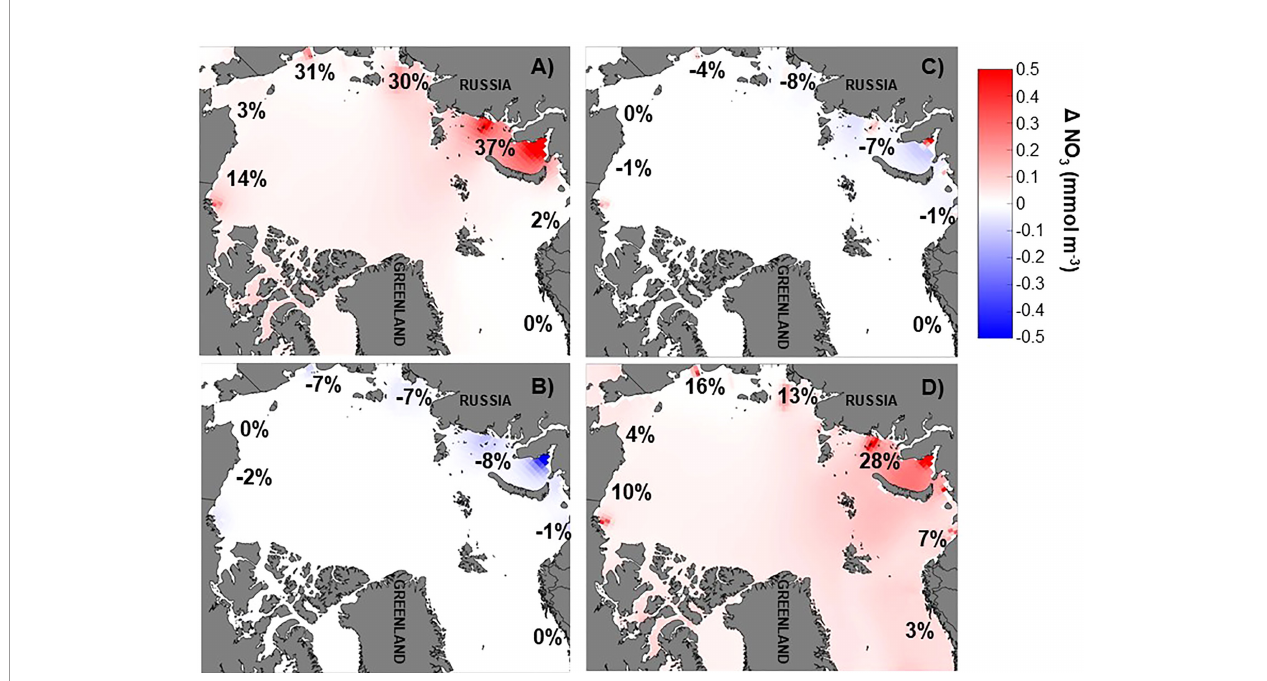
FIGURE 5 | Annual average nitrate anomaly (mmol m -3 ) in the upper mixed layer relative to the baseline run [(NO 3 ) EXP – (NO 3 ) BASE ] for (A) doubling of river nitrate (N X2 ), (B) annual river nitrate climatology (N CLIM ), (C) river nitrate climatology shifted earlier by two months (N CLIMS2 ), and (D) river nitrate climatology doubled and shifted earlier by one month (N CLIMX2S1 ). Red colors indicate increased nitrate over the baseline run while blue colors indicate lower nitrate concentrations than the baseline run. Percentage change by coastal region is also indicated. All model results presented are ten years